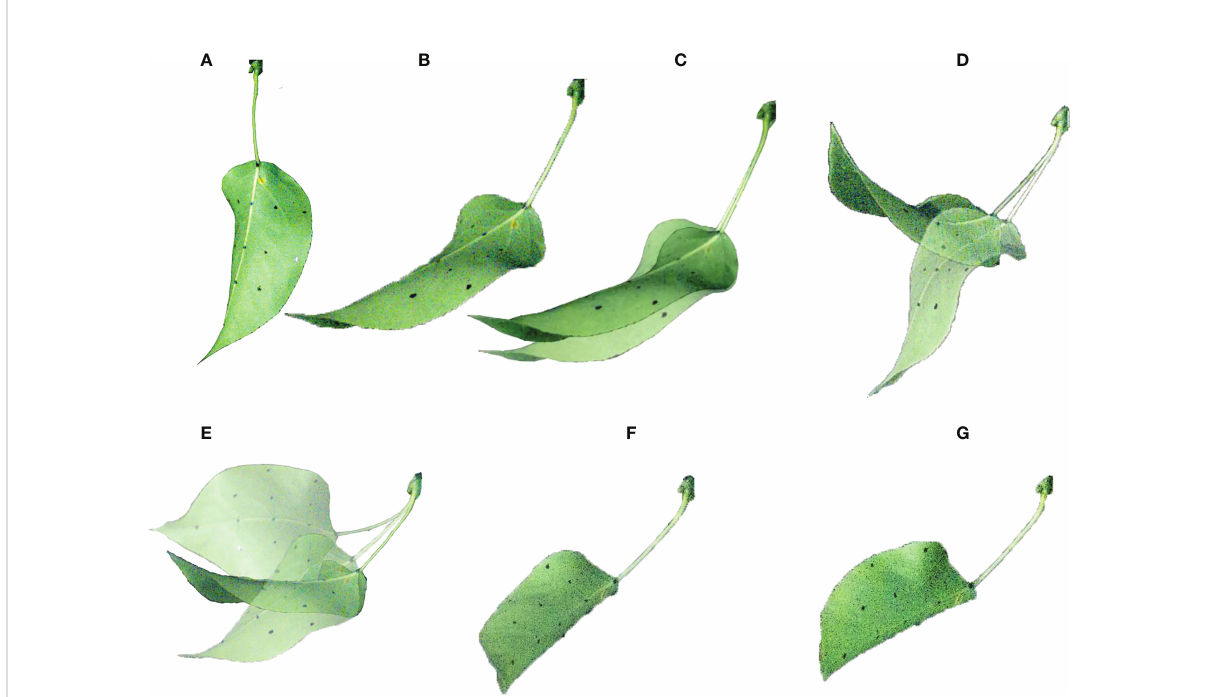
FIGURE 5 Deformation and vibration of the leaf under different air velocities. (A) v =0m/s; (B) v =2.0m/s; (C) v =2.5m/s; (D) v =3.0m/s; (E) v =3.5m/s; (F) v =4.0m/s; (G) v